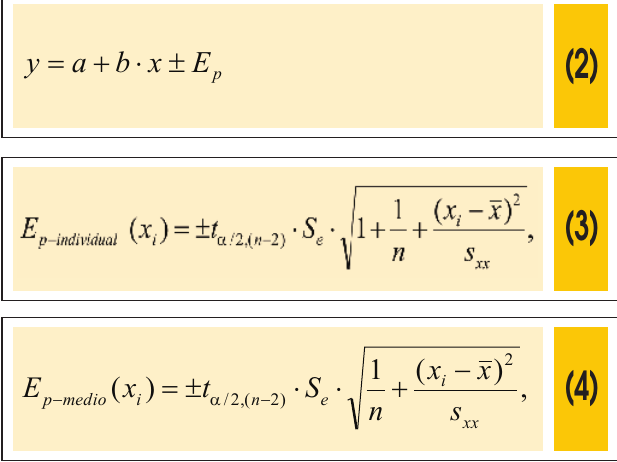
Table 2 – Average penetrated length of the probe and average gunpowder mass Average penetrated length,